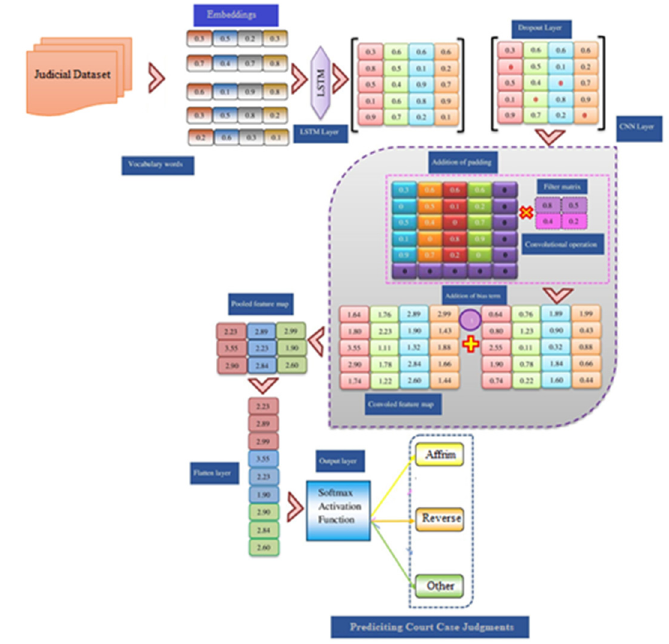
Figure 3. The suggested LSTM+CNN model’s detailed structure.